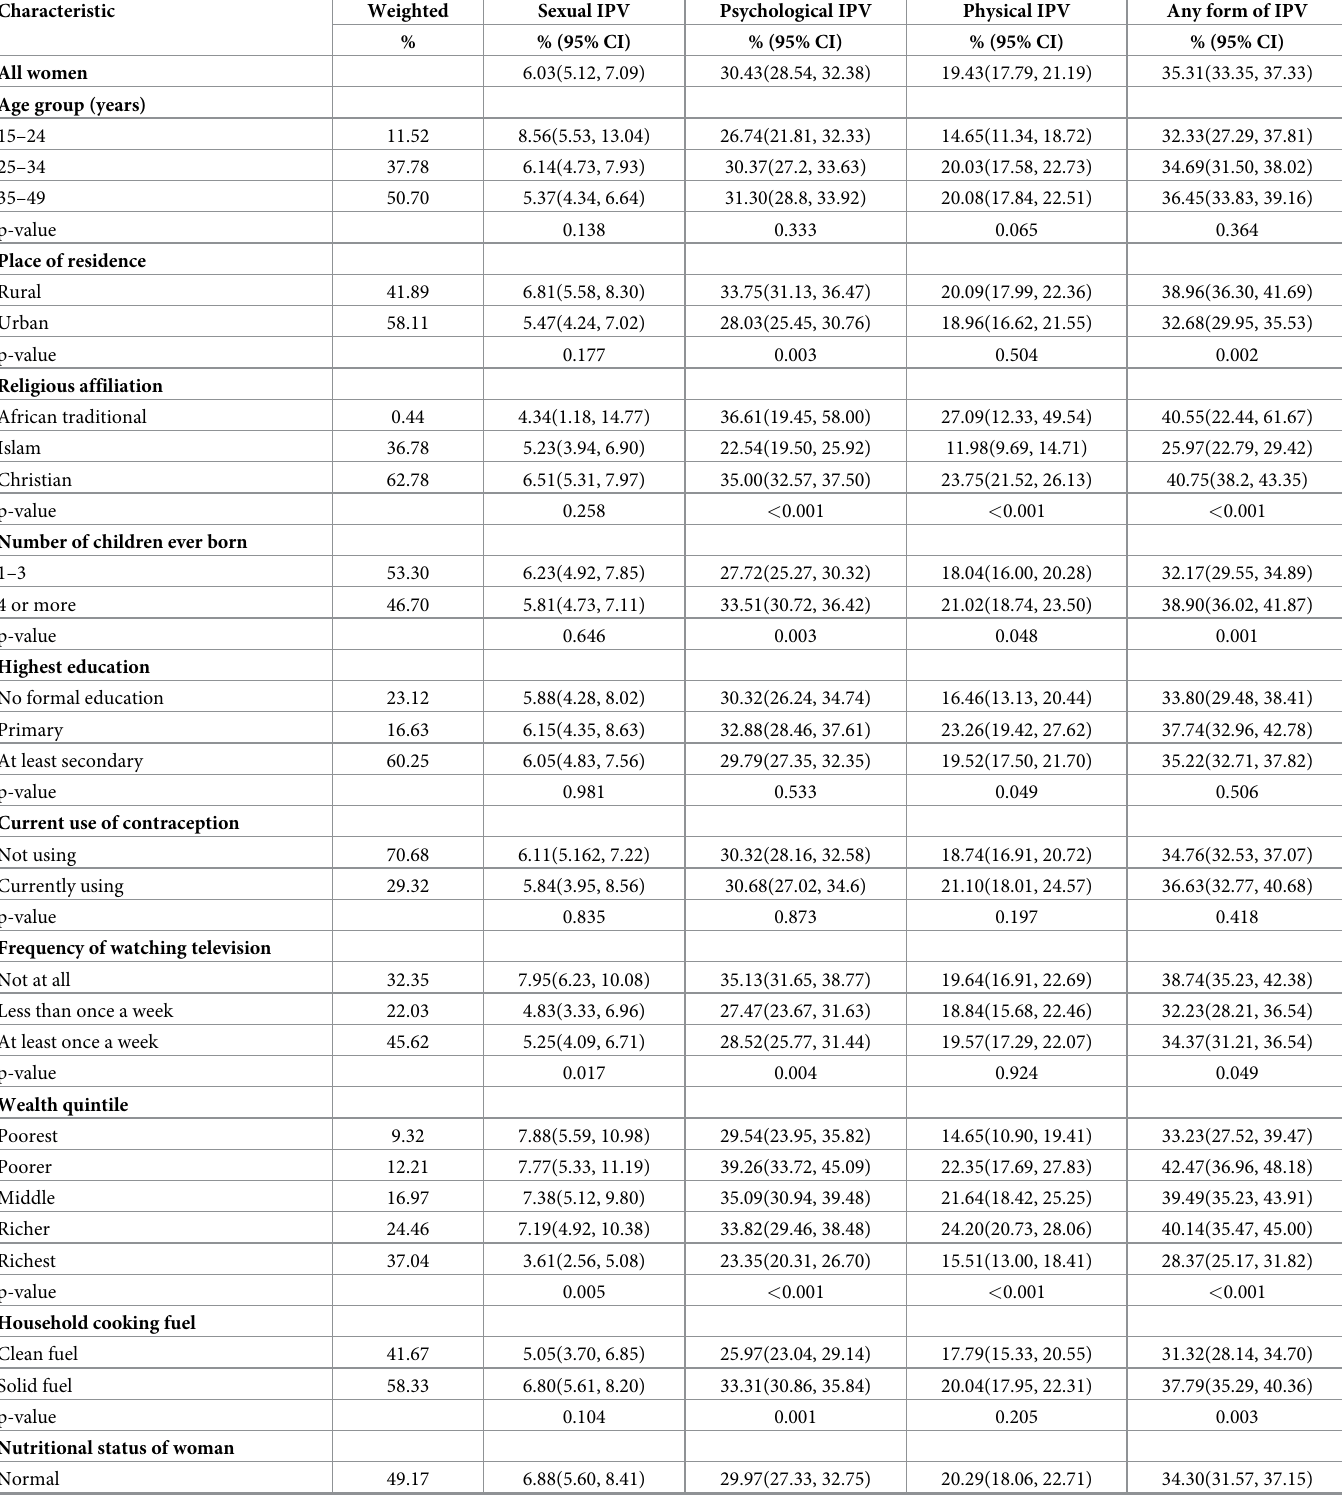
Table 1. Prevalence of types of intimate partner violence by women’s characteristics (weighted N = 4,391).